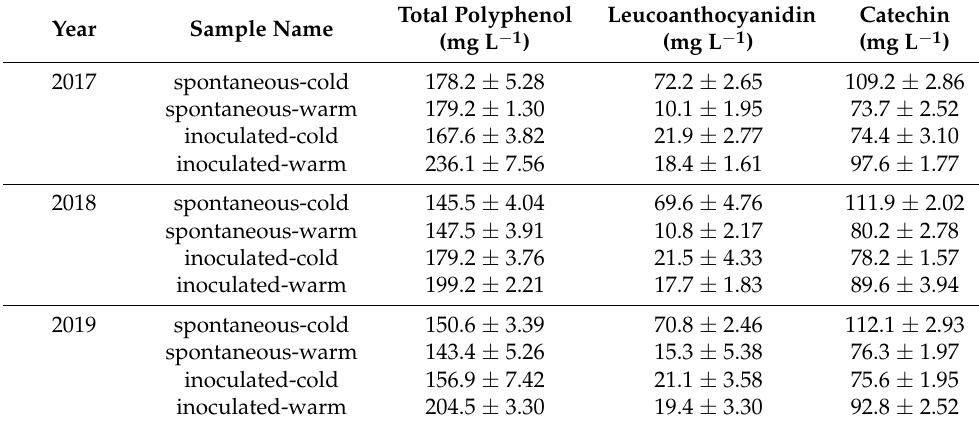
Table 3. Changes in the concentration of phenolic compounds at the end of fermentation in the wines analysed over 3 years (mean ± standard deviation of three parallel measurements).